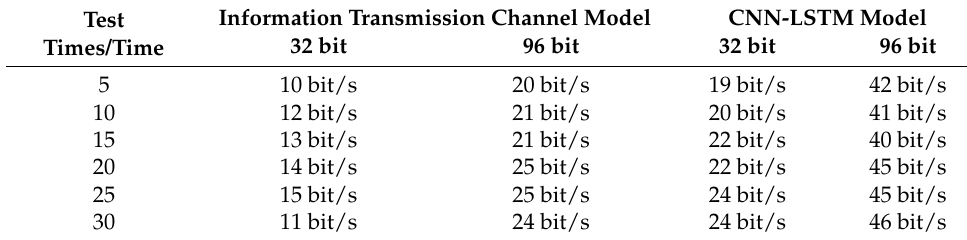
Figure 2. Comparison of different paths for transmission. ( a ) Overall efficiency of single-channel transmission; ( b ) average received bit rate of single-channel transmission; ( c ) overall efficiency of multiplexing; ( d ) average received bit rate of multiplex transmission. Table 1. Single-channel transmission rate of two methods.